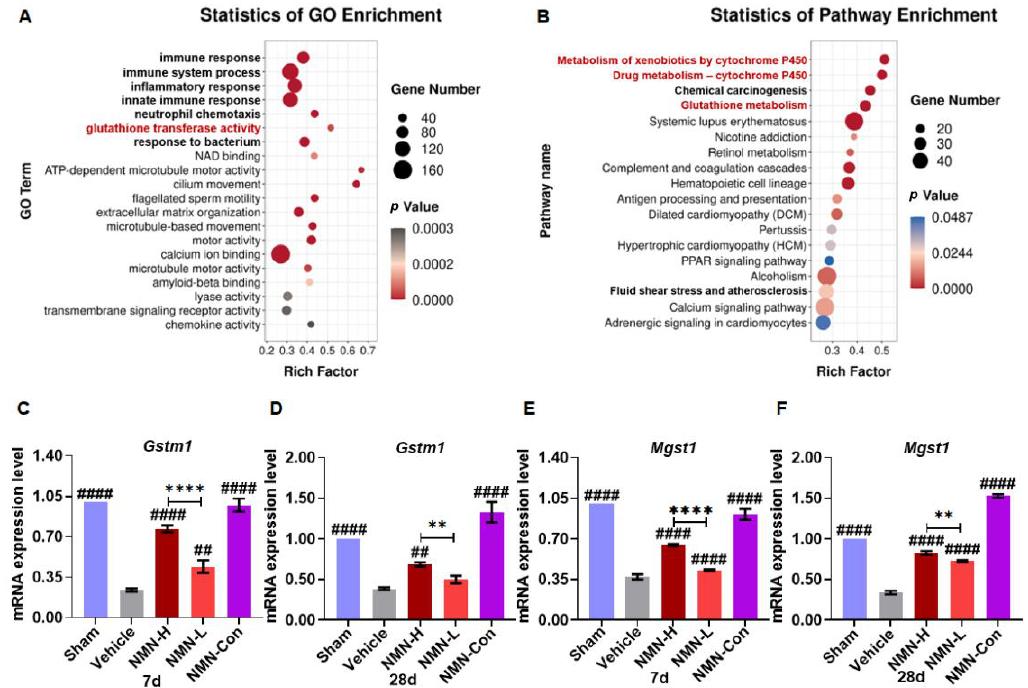
Figure 5. NMN intervention for 28 days decreases the proportion of macrophages, CD4 + CD69 + T cells, and CD8 + CD69 + T cells in silica-induced lung injury. ( A ) Proportions of macrophages in lung tissue; ( B ) proportions of CD4 + CD69 + T cells in lung tissue; ( C ) proportions of CD8 + CD69 + T cells in lung tissue. #### indicates p < 0.0001 vs. Vehicle. Sham: saline + saline; Vehicle: silica + saline; NMN-H: silica + NMN (1000 mg/kg); NMN-L: silica + NMN (500 mg/kg); NMN-Con: saline + NMN (1000 mg/kg).